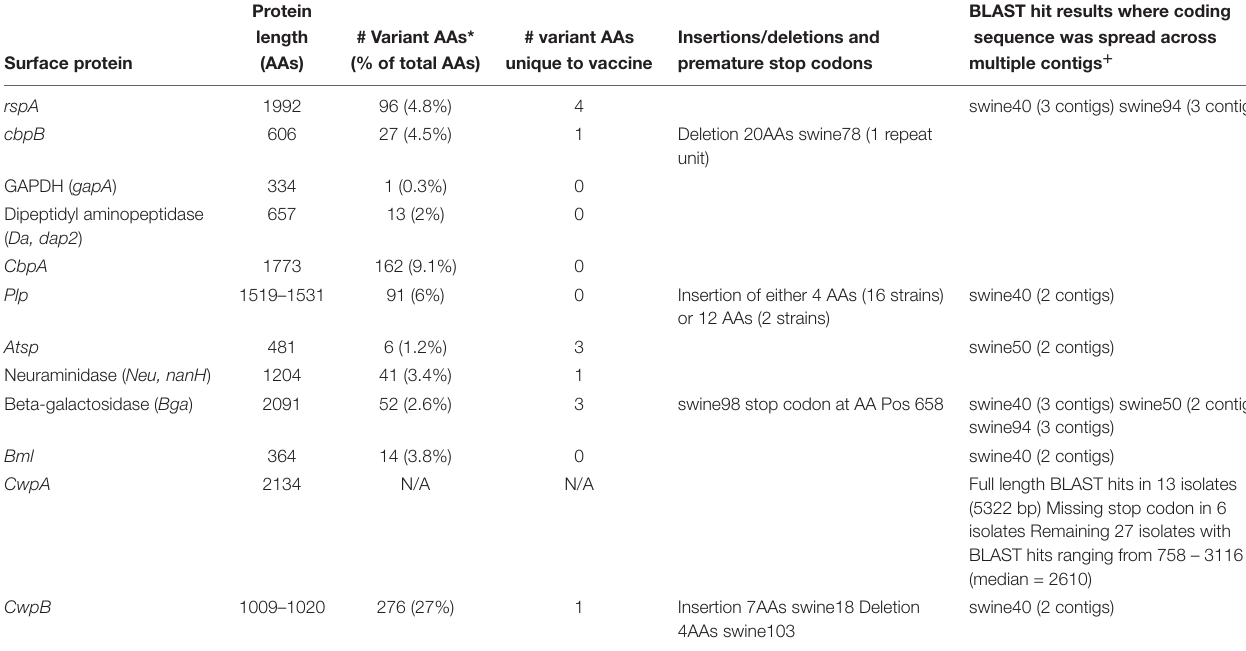
TABLE 2 | Amino acid (AA) sequence diversity in surface proteins related to immunogenicity of Erysipelothrix rhusiopathiae. Protein BLAST hit results where coding length # Variant AAs * # variant AAs Insertions/deletions and sequence was spread across Surface